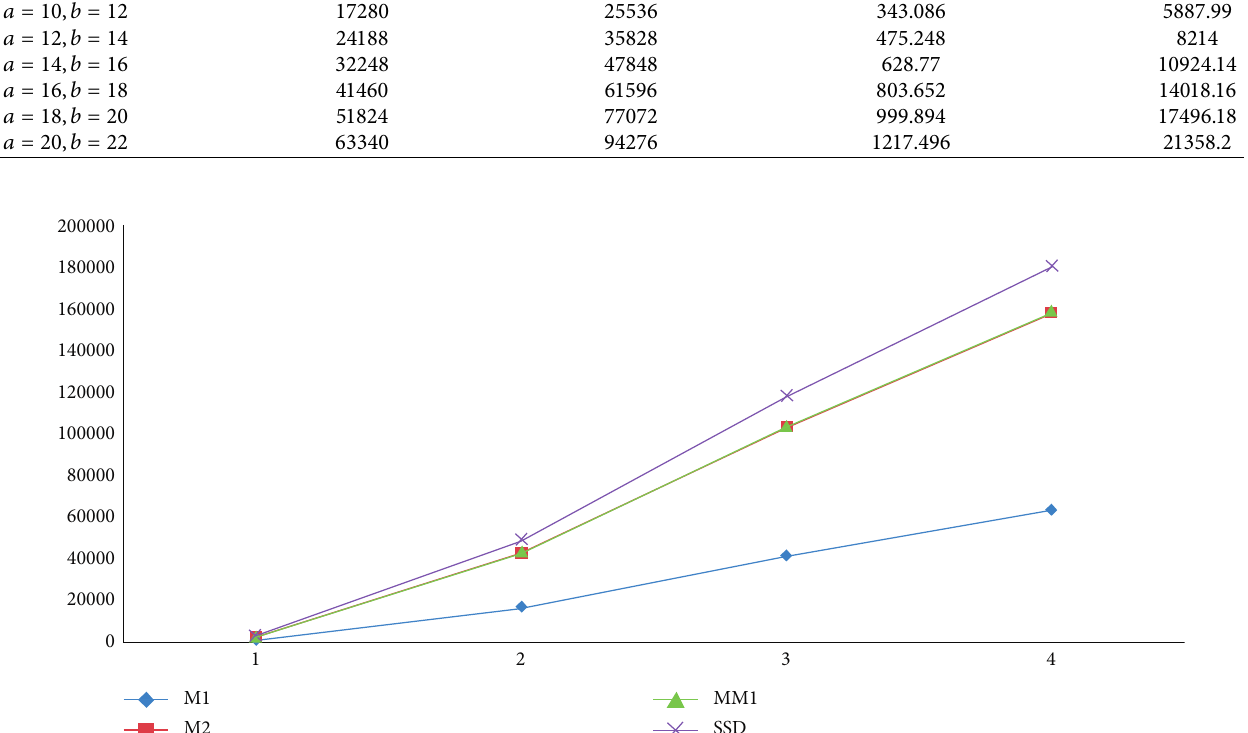
Figure 3: Graphical comparison between M MM